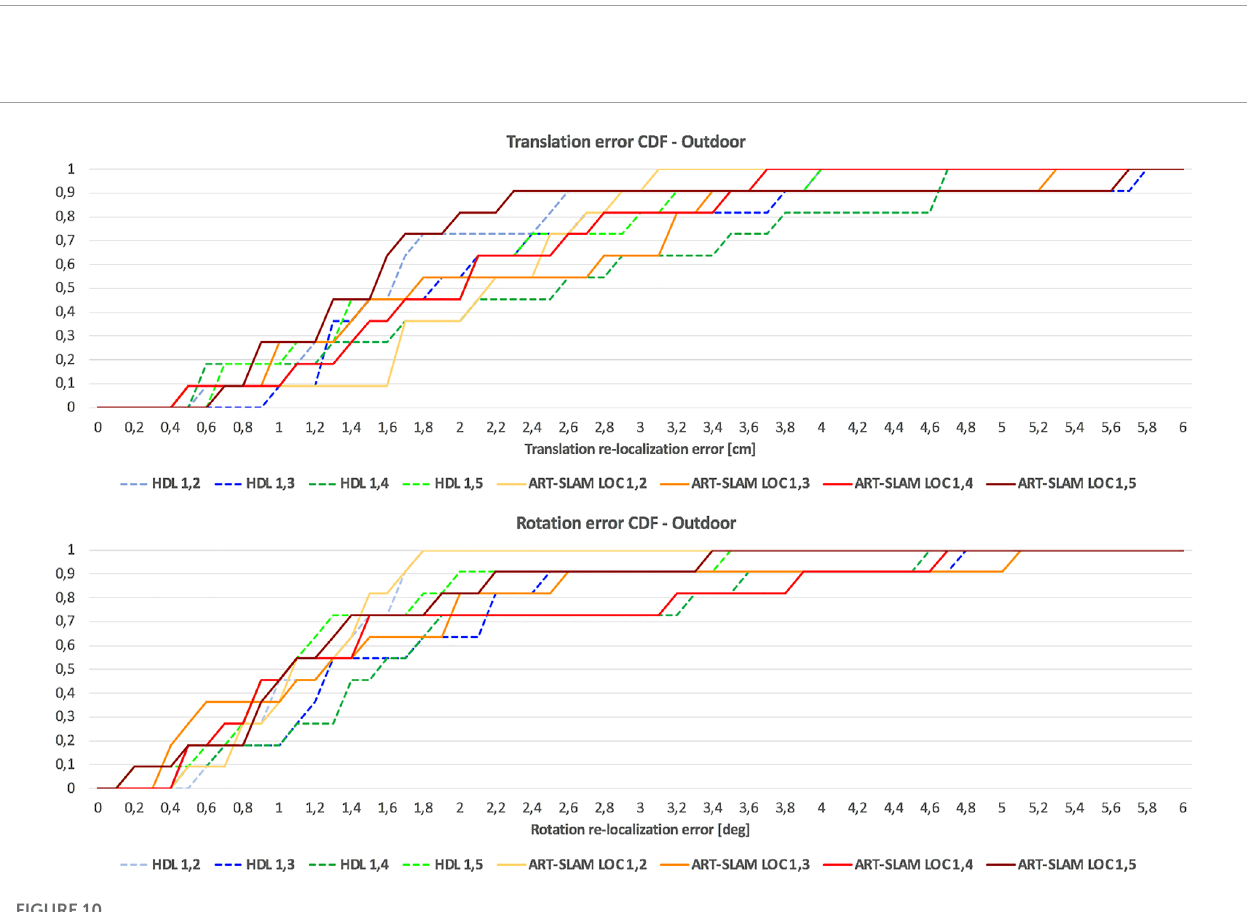
FIGURE 10 CDF of the re-localization errors of the outdoor experiment, consisting of both translational and rotational components, using HDL Koide et al. (2019) and ART-SLAM Frosi and Matteucci